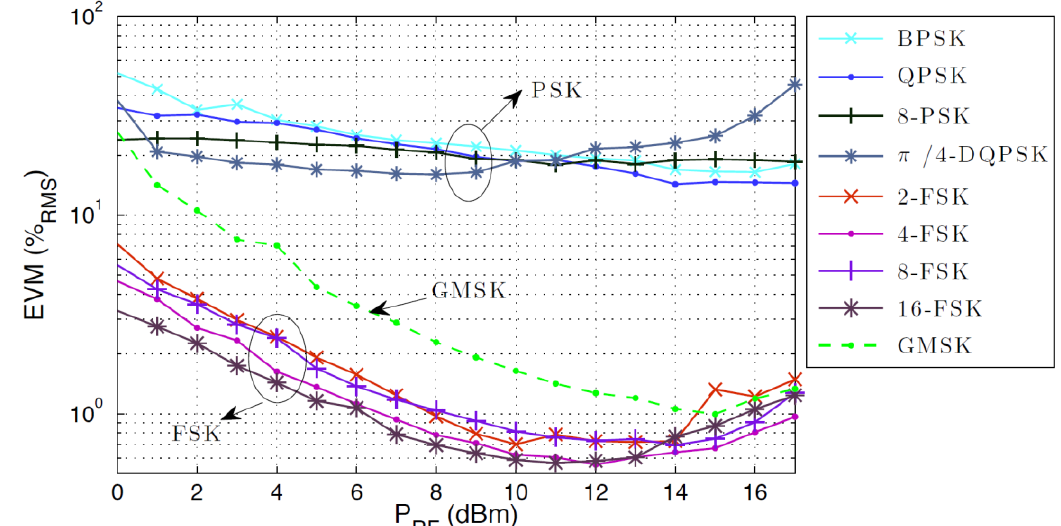
Figure 11. EVM performance comparison for PSK, FSK and GMSK modulated formats for the